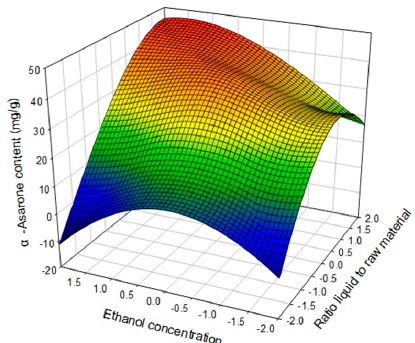
Figure 3. Response surface plot for the effects of ratio of liquid to raw material (X 1 ) and ethanol concentration (X 3 ) on α -asarone content (mg/g dried